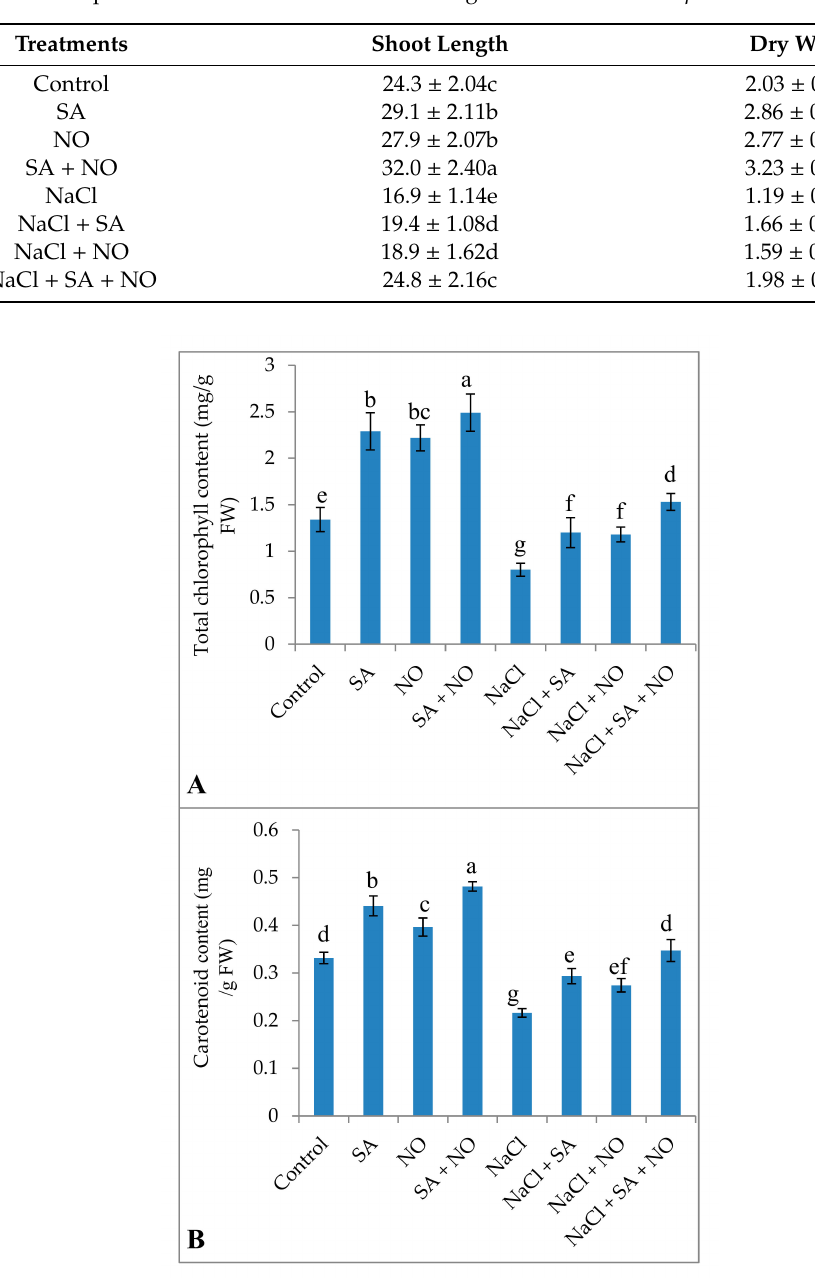
Figure 1. E ff ect of exogenous application of SA and NO on ( A ) total chlorophyll and ( B ) carotenoids in Vigna angularis under salinity (100 mM NaCl) stress. Data are the mean of four replicates and di ff erent letters show significant di ff erence at p <